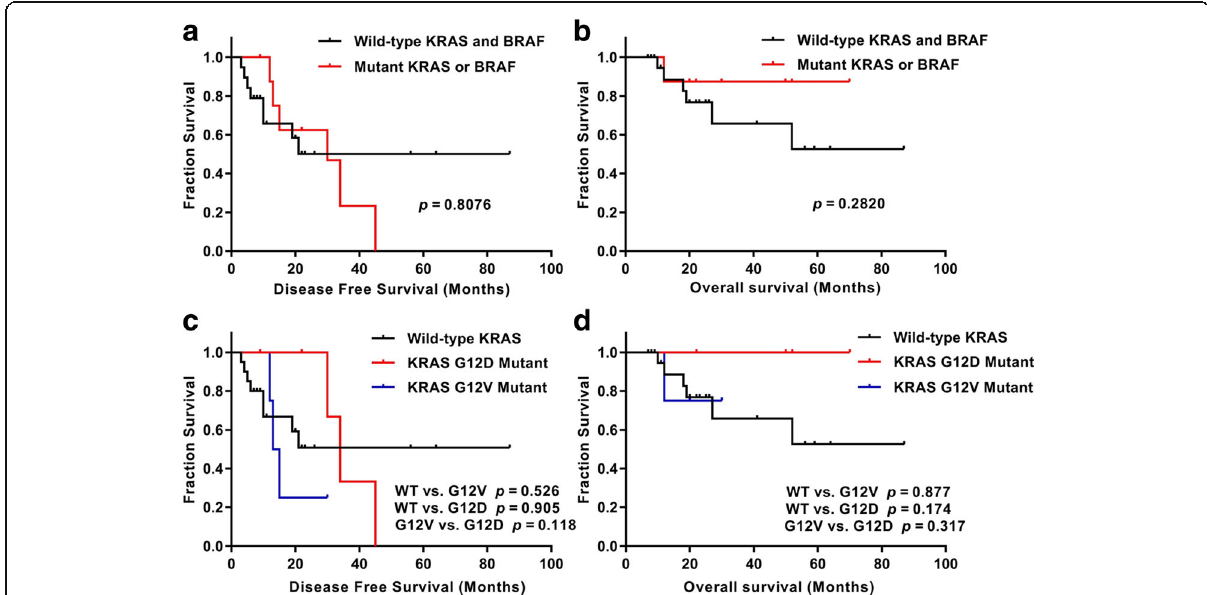
Fig. 2 DFS and OS Kaplan – Meier analyses in ovarian LGSC. a and b No significant differences were found between patients with KRAS/BRAF mutations and those with wild-type KRAS/BRAF genes ( P = 0.8076 for DFS, and P = 0.282 for OS). c and d Three KRAS mutation subtypes were not significantly correlated with DFS ( c ) or OS ( d ), but there was a favorable prognostic trend for KRAS G12D mutation compared with wild-type and G12 V mutation in OS ( d